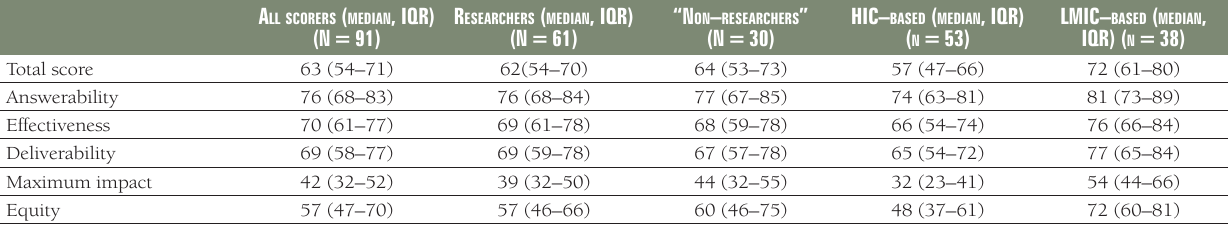
Table 1. The differences in median scores (with inter–quartile range, IQR) that different sub–groups of scorers (ie, researchers vs “non–researchers”; and high–income country (HIC)–based vs low– or middle–income country (LMIC–based) assigned to different criteria*